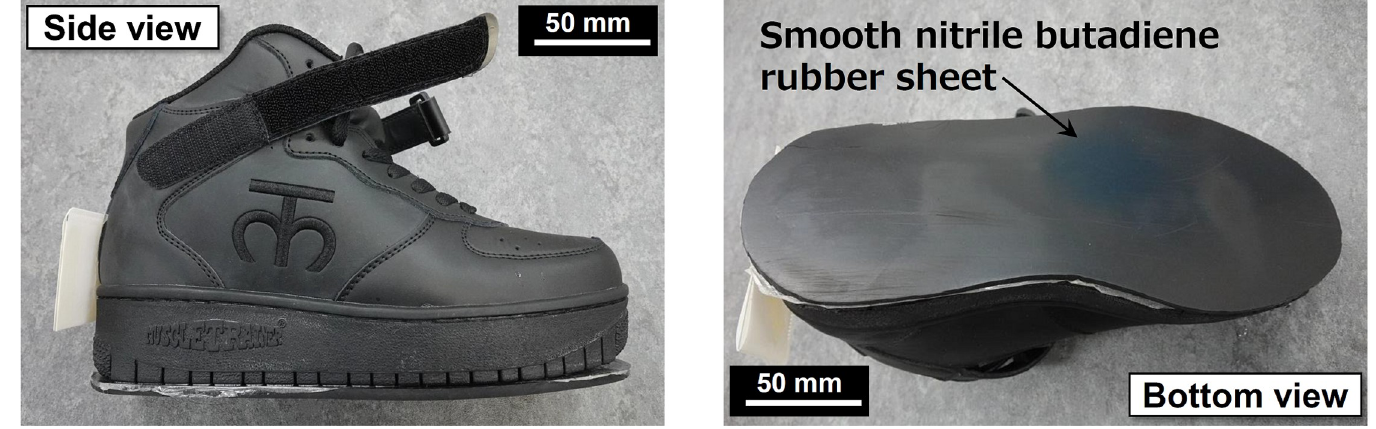
Fig 2. Photos of test shoe